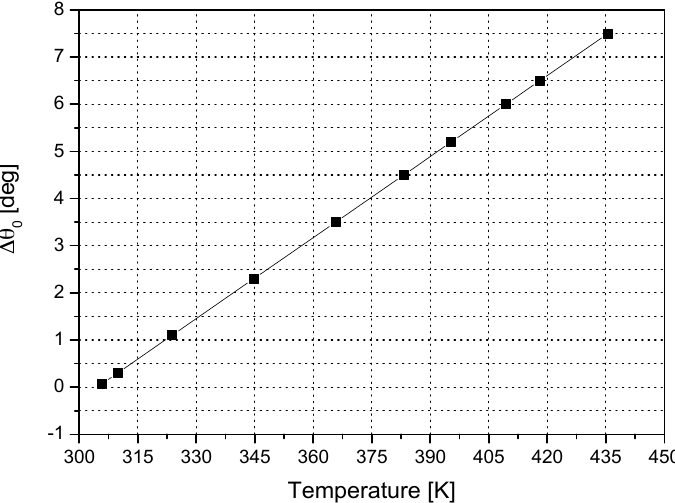
Figure 2. Measured optical activity vs. the temperature of the Bi 12 GeO 20 crystal.